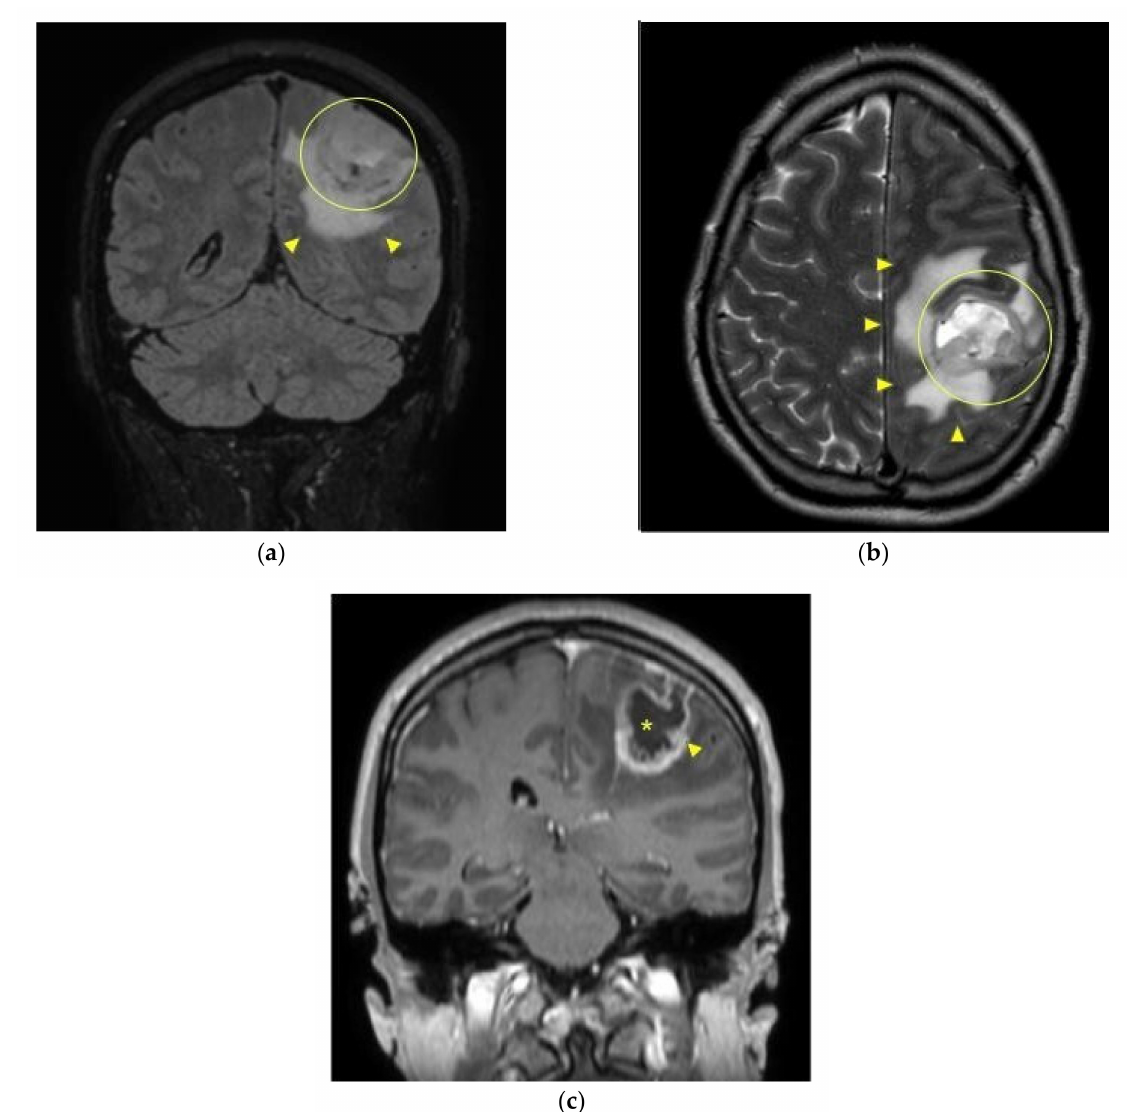
Figure 3. Brain MRI. A 3 cm left parietal solid mass (circle) surrounded by edema is demonstrated at brain MRI; its characteristics are typical for gliobastoma. Coronal FLAIR image (T2-weighted with CSF suppression; ( a ) and T2-weighted axial image ( b ) show hyperintense lesion (circle) with heterogeneous signal because of hemorragic intralesional foci and flow voids, surrounded by edema (arrowhead). In ( b ) both solid peripheral ring and necrotizing/hemorragic intralesional foci are better depicted. Coronal T1-weighted image after contrast ( c ) shows peripheral and irregular enhancement with nodular components (arrowhead), that surround necrosis